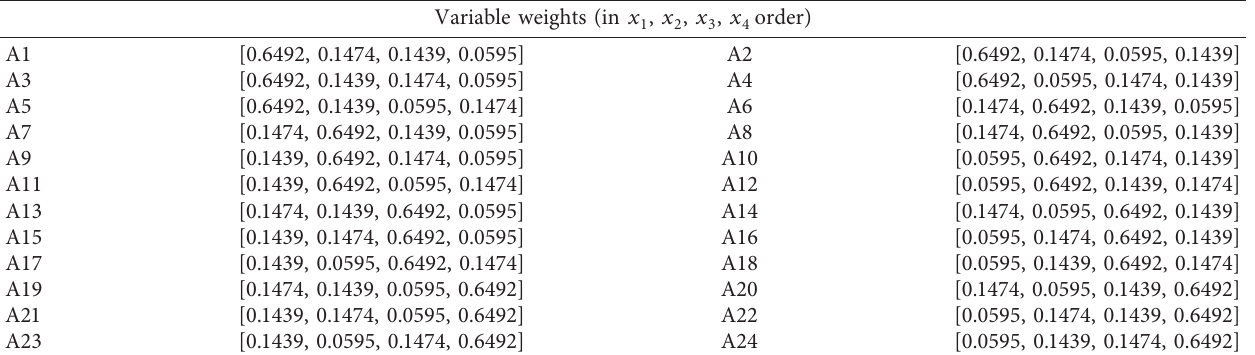
Table 3: The output result of the optimal weight of each variable under all